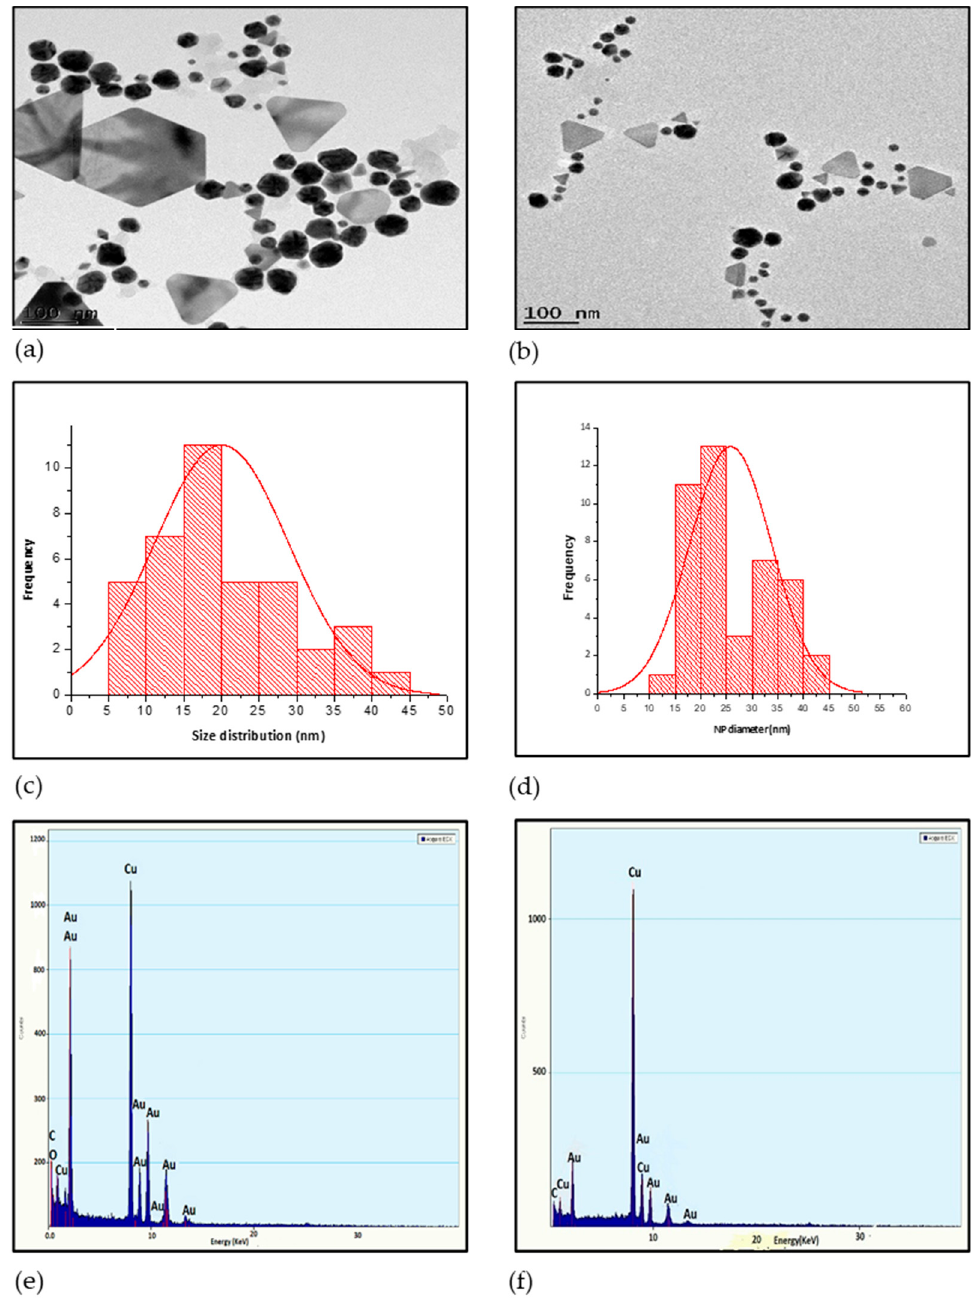
Figure 2. Morphology and energy dispersive X-ray spectroscopy (EDX) profiling of the biogenic AuNPs. High-resolution transmission electron microscopy (HR-TEM) micrographs of HB-AuNPs ( a ) and MGF-AuNPs ( b ); particle size distribution of HB-AuNPs ( c ) and MGF-AuNPs ( d ); EDX profiles of HB-AuNPs ( e ) and MGF-AuNPs ( f ) for their chemical composition. EDX was employed to analyze the composition of the AuNPs. The result clearly con- firmed the presence of Au in both HB-AuNPs (Figure 2e) and MGF-AuNPs (Figure 2f). The peaks that correspond to Cu and C in the EDX spectra of the two AuNPs could be due to the carbon-coated copper grid, while the O in the HB-AuNPs could be from one of the phytochemicals present in the HBE, as previously argued by Wang et al. [37]. The XRD and Selective Area Electron Diffraction (SAED) patterns in Figure 3 demon- strated the crystalline nature of the HB-AuNPs and MGF-AuNPs. The XRD pattern for the two AuNPs revealed five peaks corresponding to standard Bragg’s reflection (111),